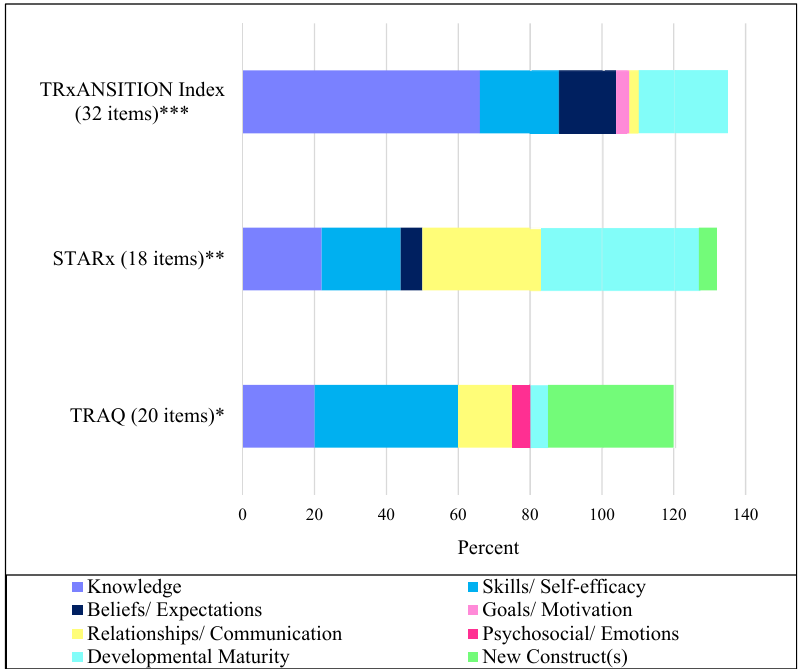
Figure 1: Proportion of items on the TRxANSITION Index, STARx and TRAQ mapping to expanded SMART model constructs. Scale range extends beyond 100% to accommodate items from